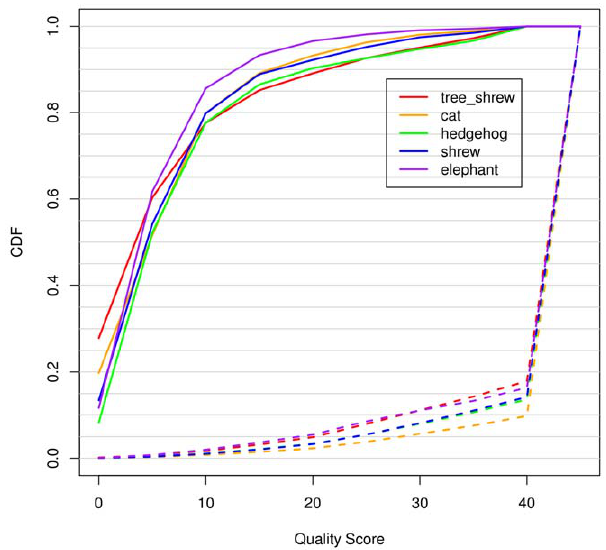
Figure 2. Cumulative distribution functions (CDFs) of quality scores and basecall errors. Results are shown for four representative 2 6 assemblies. At each quality score threshold q , shown on the x axis, the dashed lines indicate the fraction of all bases having quality score q , and the solid lines indicate the fraction of all basecall errors that are associated with bases having quality score q . This graph highlights the fact that most bases have high quality scores, but most errors derive from bases with low quality